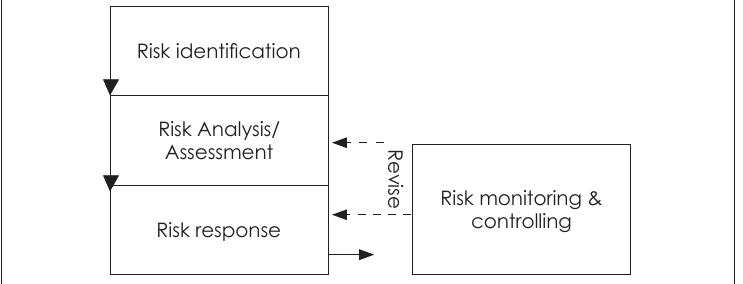
Figure 1: Risk management